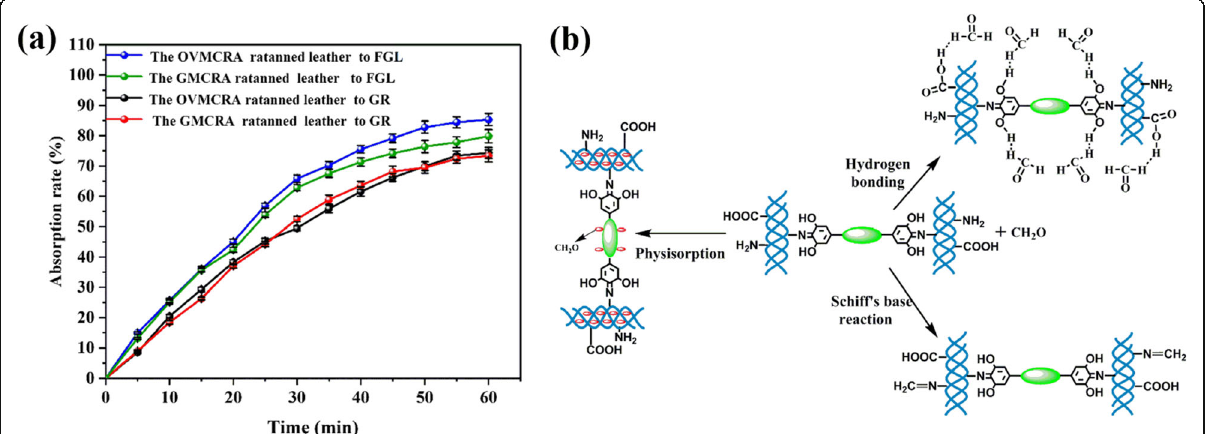
Fig. 4 a Absorption rate of the retanned leather to dyes. FGL: blue cationic dye-FGL, GR: deep blue acid dye-GR, OVMCRA: oxidized valonia extract-modified collagen retanning agent, GMCRA: commercial modified protein retanning agent; and b Reaction mechanism of